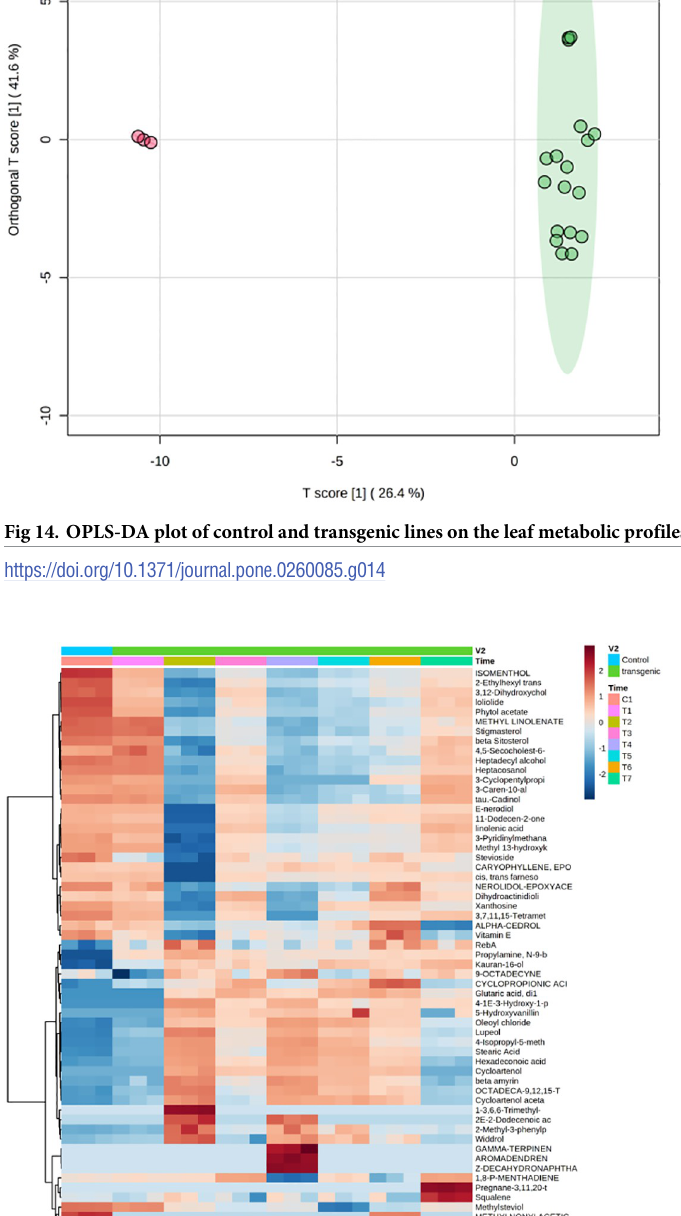
PLOS ONE | https://doi.org/10.1371/journal.pone.0260085 February 6,